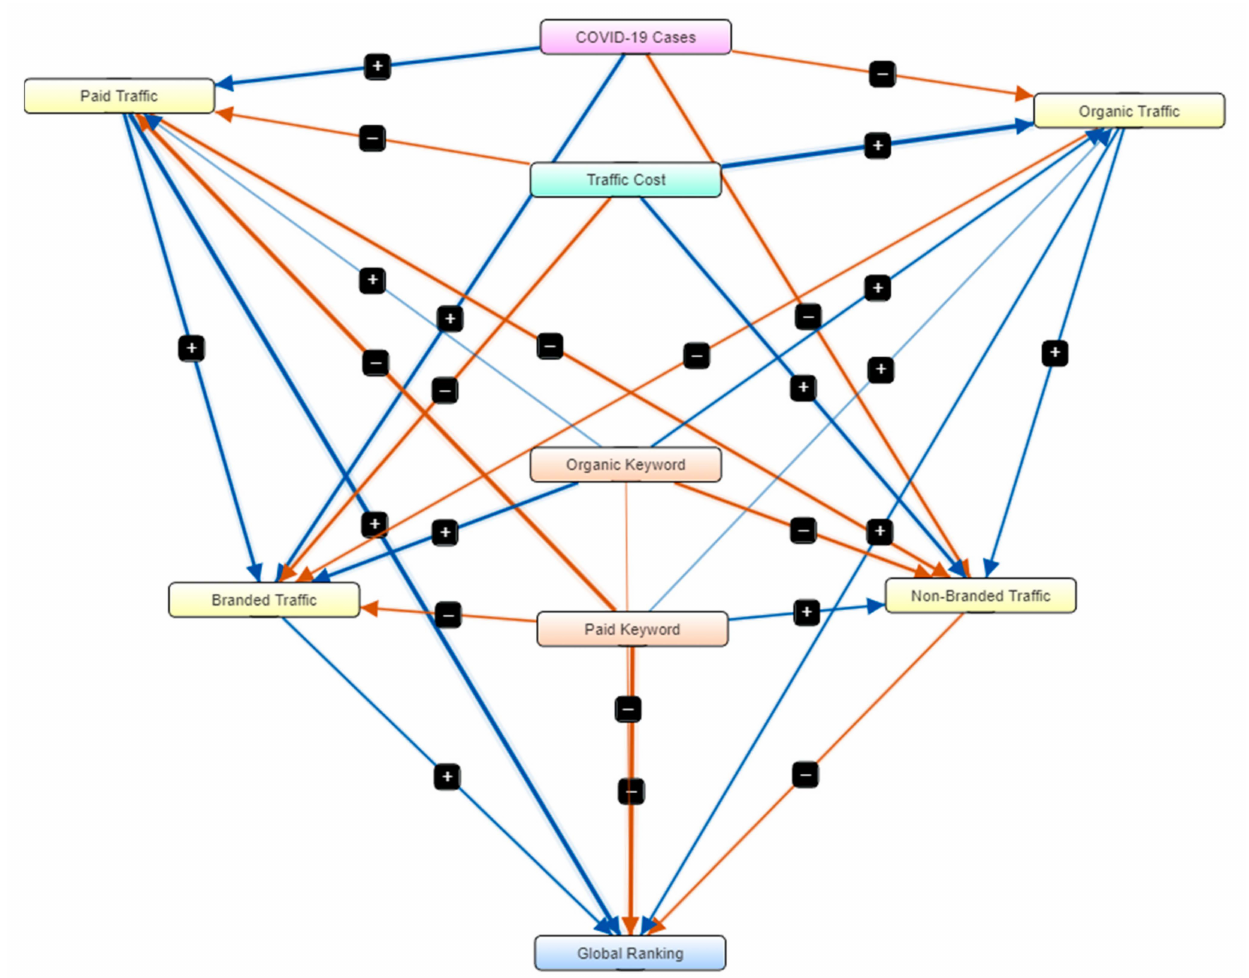
Figure 4. Fuzzy cognitive mapping (FCM) of the variables studied during the “crisis within a crisis effect” period. Blue and red arrows signify positive and negative correlations between variables